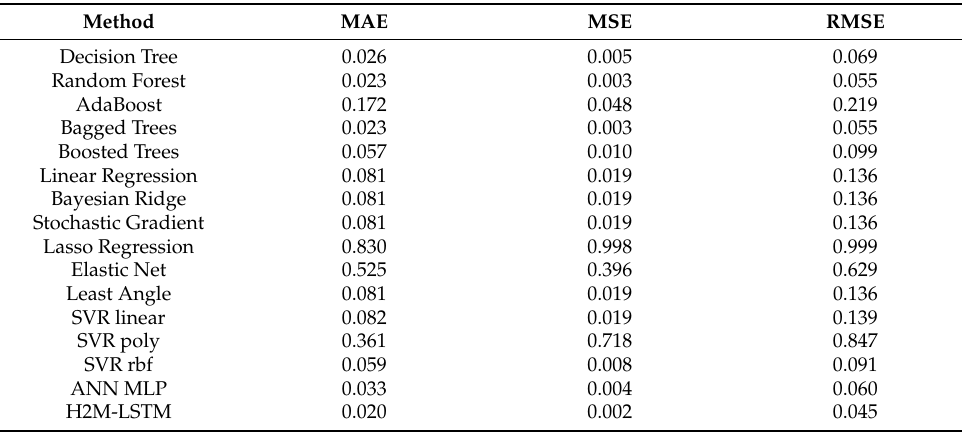
Figure 8. Barplot comparison of the best performance metrics for the solar panels. Table 3. Performance metrics for the heat exchanger.